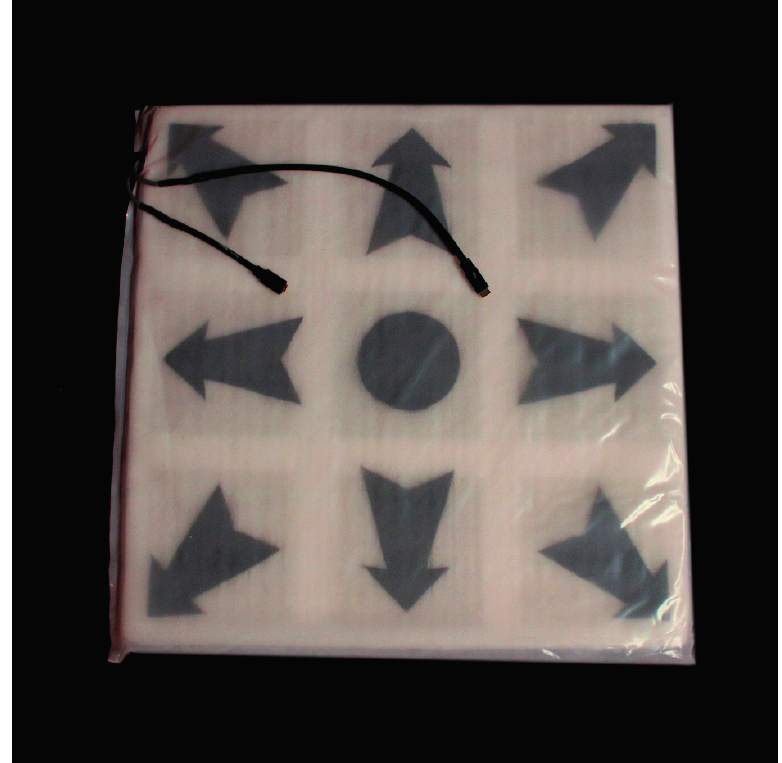
Figure 1. The exercise pad used in the